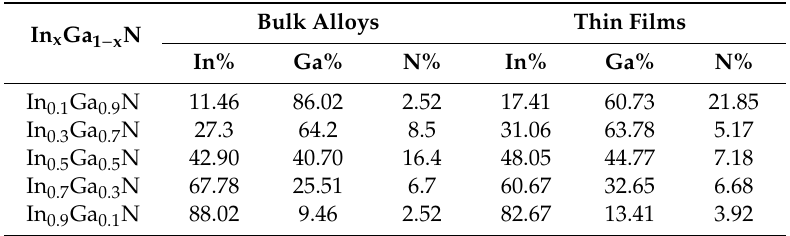
Table 1. Energy dispersive X-ray spectroscopy technique (EDX) measurements of In x Ga 1 − x N bulk alloys and thin films.